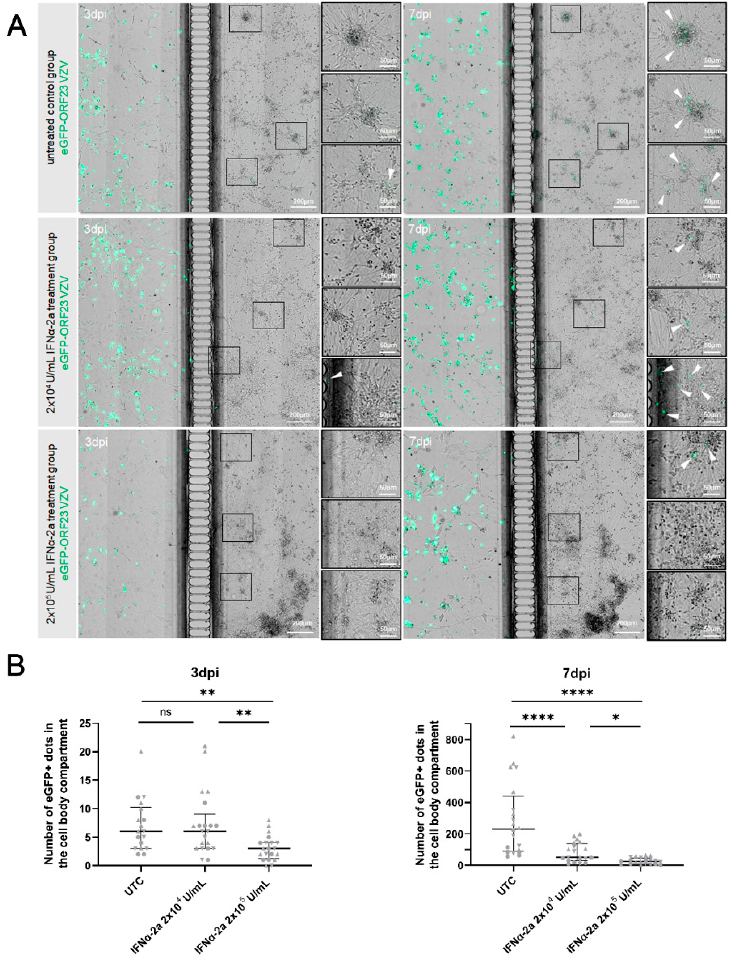
Figure 6. Exogenous IFN α limits VZV spread in the neuronal cell body compartment upon axonal infection. ( A ) Representative images of sections of neuronal cultures at 3 dpi (left panels) and 7 dpi (right panels) are shown for each condition: untreated control cultures (UTC: upper panel), 2 × 10 4 U/mL (lower dose: middle panel) and 2 × 10 5 U/mL (higher dose: lower panel) IFN α -2a treatment group. Axon termini were inoculated with 7.3 × 10 3 PFU ARPE-19-associated eGFP-ORF23 VZV. Arrow heads indicate eGFP+ dots in the neuronal cell body compartment arising from VZV ORF23 expression. ( B ) Quantification of the number of eGFP+ dots arising from VZV ORF23 expression in the cell body compartment. Median number of eGFP+ dots across experiments at 3 dpi: UTC: 6, 2 × 10 4 U/mL IFN α -2a treatment group: 6, 2 × 10 5 U/mL IFN α -2a treatment group: 3. Median number of eGFP+ dots across experiments at 7 dpi: UTC: 231, 2 × 10 4 U/mL IFN α -2a treatment group: 51.5, 2 × 10 5 U/mL IFN α -2a treatment group: 25. Each symbol represents the number of eGFP+ dots in the cell body compartment of a single culture originating from one of three independent biological repeats (3 dpi: Experiment 1: circles, n = 6/7/6; Experiment 2: triangles, n = 7/8/8; Experiment 3: upside down triangles, n = 5/6/6; 7 dpi: Experiment 1: circles, n = 6/6/6; Experiment 2: triangles, n = 8/8/8; Experiment 3: upside down triangles, n = 6/6/6). Lines with whiskers indicate the median with interquartile range from the three independent experiments combined. The p values reported were obtained from a Linear Mixed Model that was adjusted for multiple testing using Tukey HSD all-pairwise comparison test. * p < 0.05, ** p < 0.01, **** p < 0.0001. ns: not